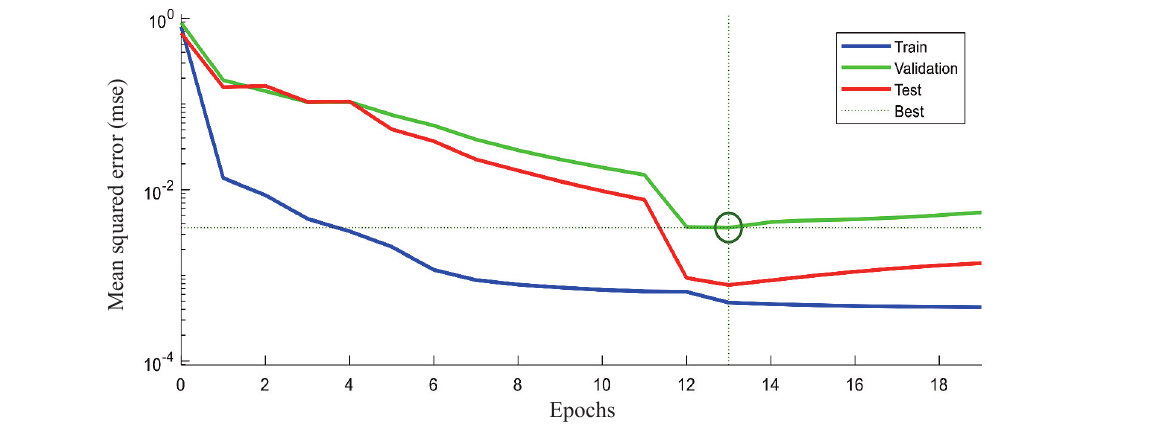
Fig. 4. The mean squared error of the ANN